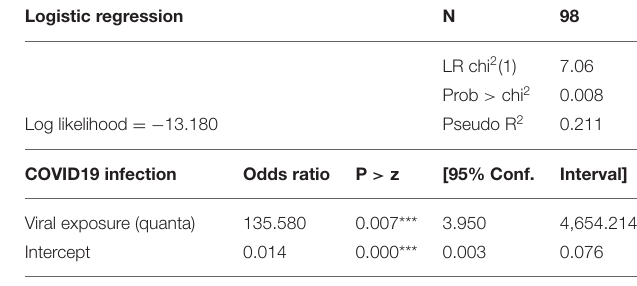
TABLE 1 | Logistic regression of the diagnosed SARS infection vs. predicted viral exposure at apartment level, all four buildings (Blocks B–E). Logistic regression